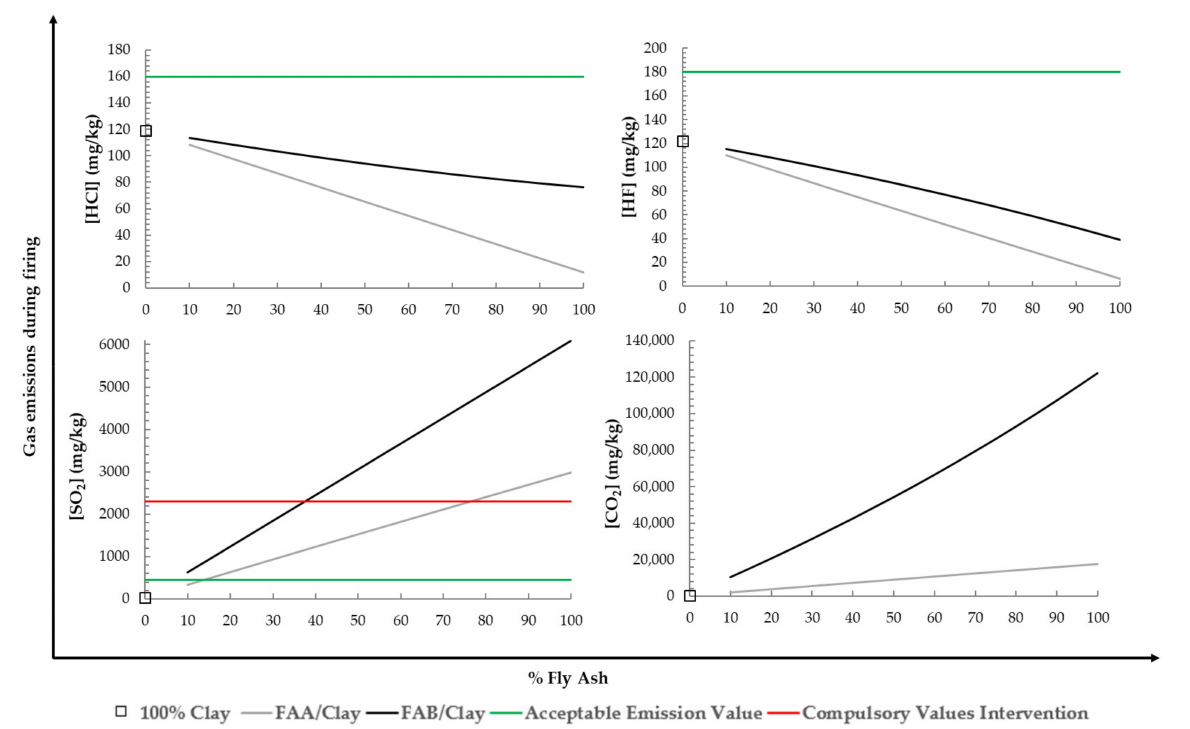
Figure 12. Estimation of HCl, HF, SO 2 , and CO 2 emissions for mixtures performed with FAA/clay B and FAB/clay B during the firing process including reference emission values proposed by I. Gonzalez et al.